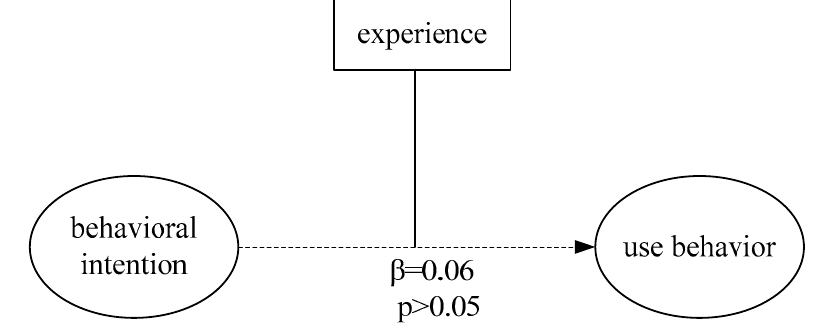
Figure 7. Seven variables and experience moderator removed the effect of behavioral intention on use behavior within the model.